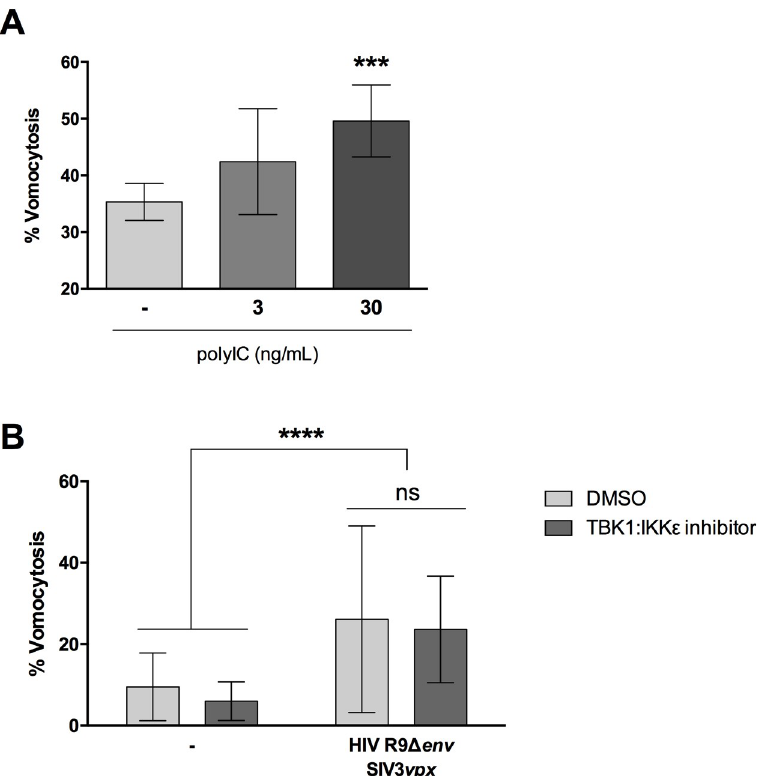
Fig 4. Viral enhancement of vomocytosis is not TBK1:IKK ε dependent. Human monocyte-derived macrophages were stimulated with different doses of polyIC ( A ) or infected with attenuated HIV ( B ), and subsequently infected with C . neoformans . In B , infection was carried out in the presence or absence of TBK1:IKK ε inhibitor (dark gray). Time- lapse microscopy videos were manually scored for vomocytosis. Graphs show Mean + SD of percentage of Cryptococcus -infected macrophages which have experienced at least one vomocytosis event. Chi 2 test followed by Fisher’s exact test performed on raw vomocytosis counts. Pooled data from at least three independent experiments.